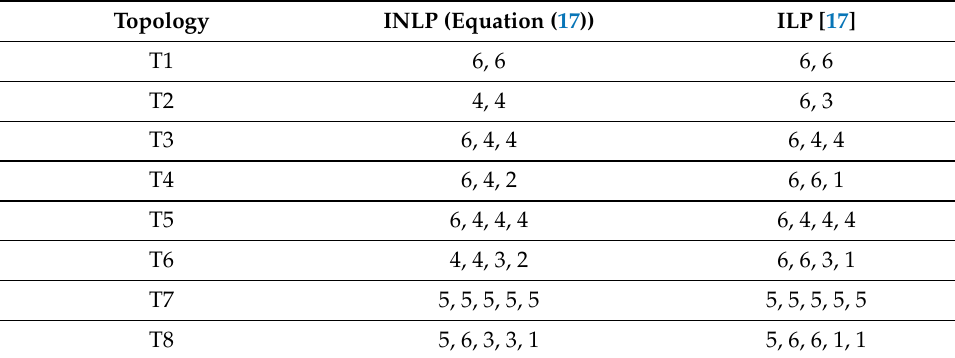
Table 5. Optimal bundling numbers.